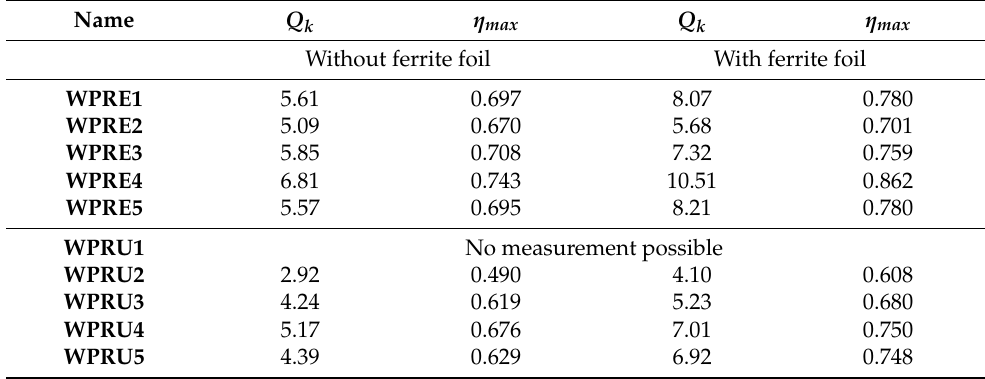
Table 8. Results for transmission quality Q k and maximum efficiency η max of test series